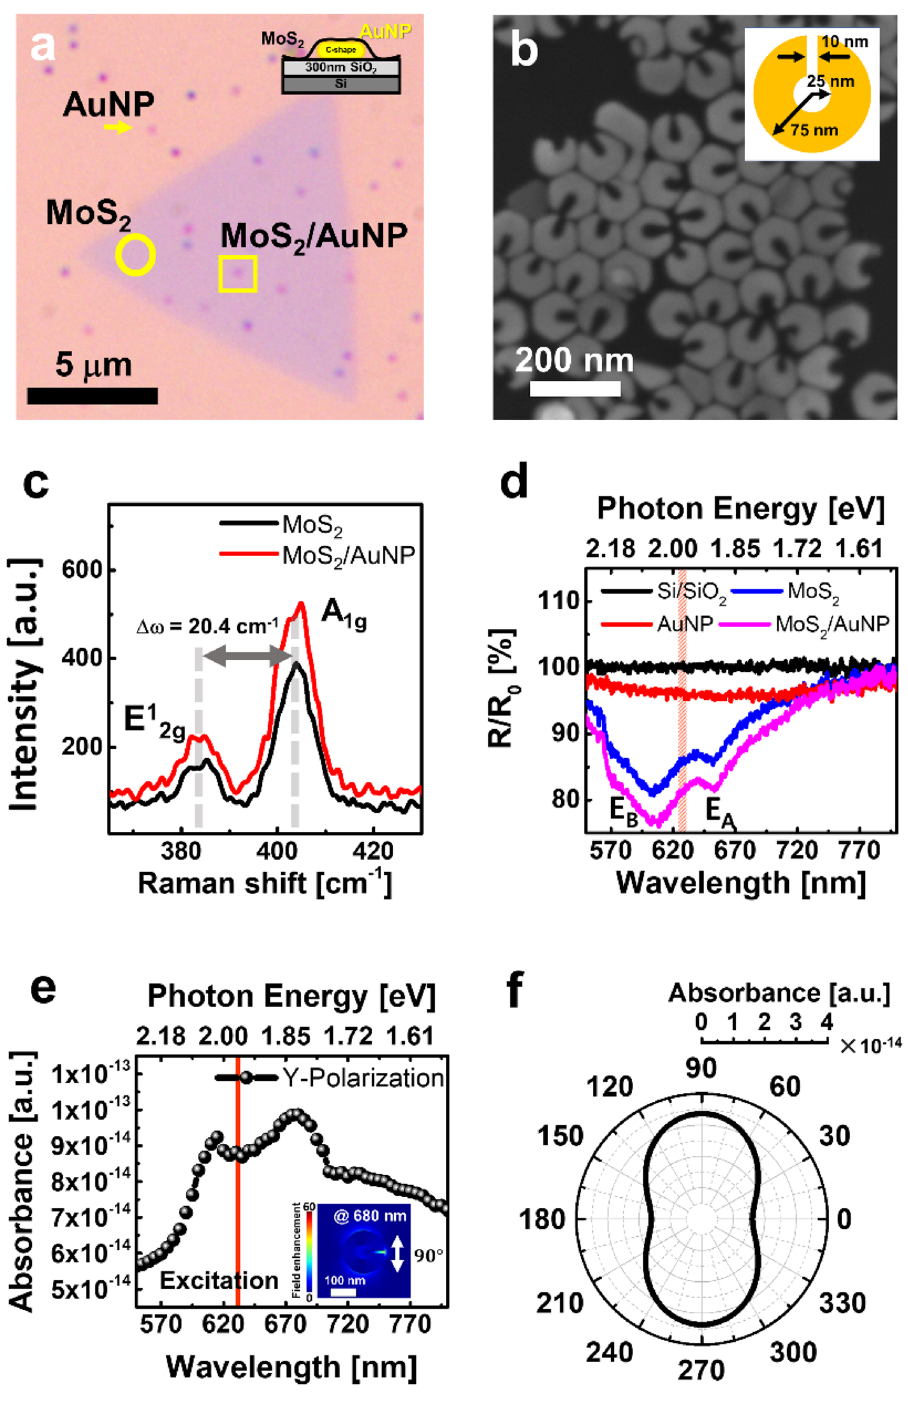
Figure 1. Monolayer MoS 2 /AuNP characterization. ( a ) Optical image of monolayer MoS 2 /AuNP hybrid. The inset is cross-sectional schematics of structure. ( b ) SEM image of non-centrosymmetric AuNP. The inset represents a dimension of AuNP. ( c ) 532 nm excitation Raman scattering spectra. ( d ) The relative reflectance spectra in the 550 ~ 800 nm range. Si/SiO 2 was set as the reference surface. ( e ) Simulation result of absorbance spectrum on the AuNP, which result set the 90 degrees of incident polarization. The red line indicates the resonance excitation wavelength of 632.8 nm. The inset shows the electric field distribution of AuNP. ( f ) FEM simulation result of polarization dependence absorbance